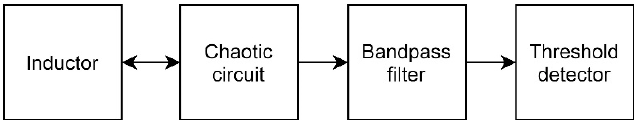
Figure 17. Overall detection scheme.